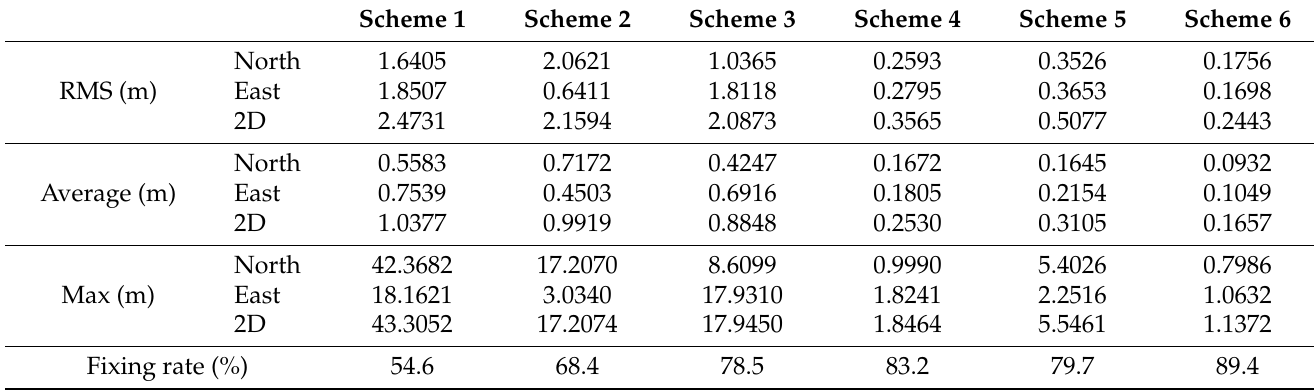
Figure 10. Experimental results under different schemes. ( a ) Positioning trajectory results. ( b ) CDF of the positioning errors. Table 6. Comparison of the RMS accuracies, average and maximum errors, and ambiguity fixing rates under the different